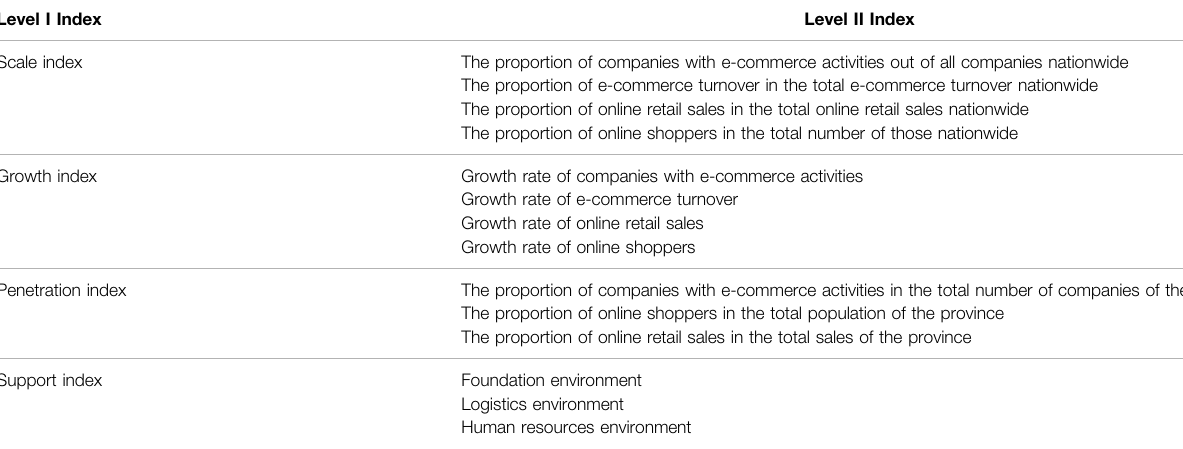
TABLE 1 | E-commerce development index